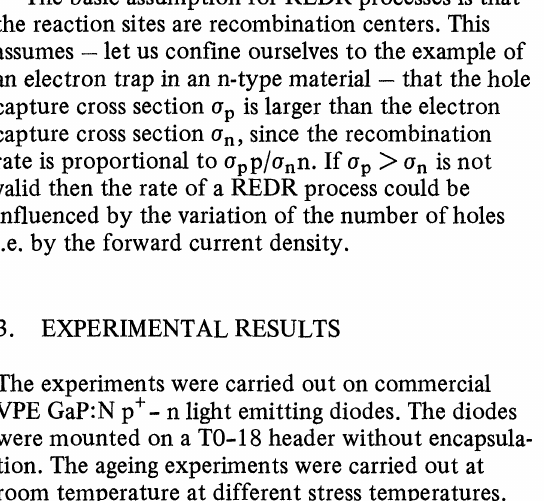
FIGURE Reduced reverse bias spectrum. The diode was stressed at 25C and 160 A/cm dc. Ageing times: Oh,. 83 h,---830 h. rected thermal activation energy is 0.49 eV from the conduction band. Using the minority carrier life- times efficiency variation data Figure 2 we assumed a